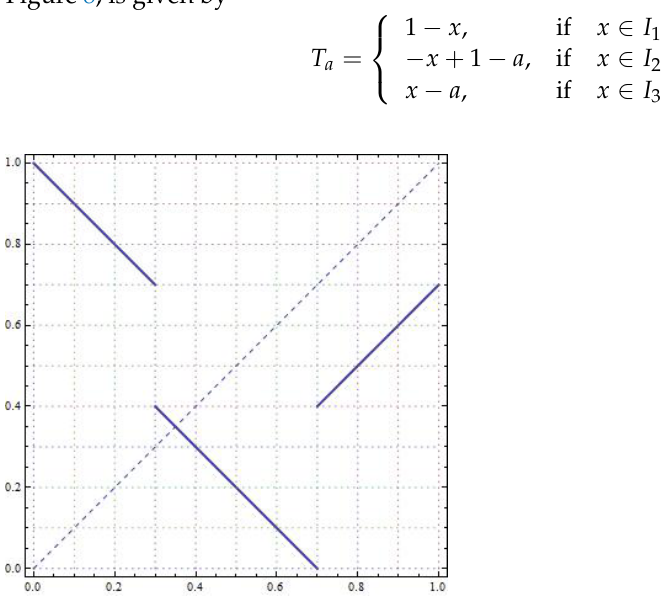
Figure 8. Graph of the ( 3,2 ) -IET with permutation ( − 3, − 1,2 ) and a =